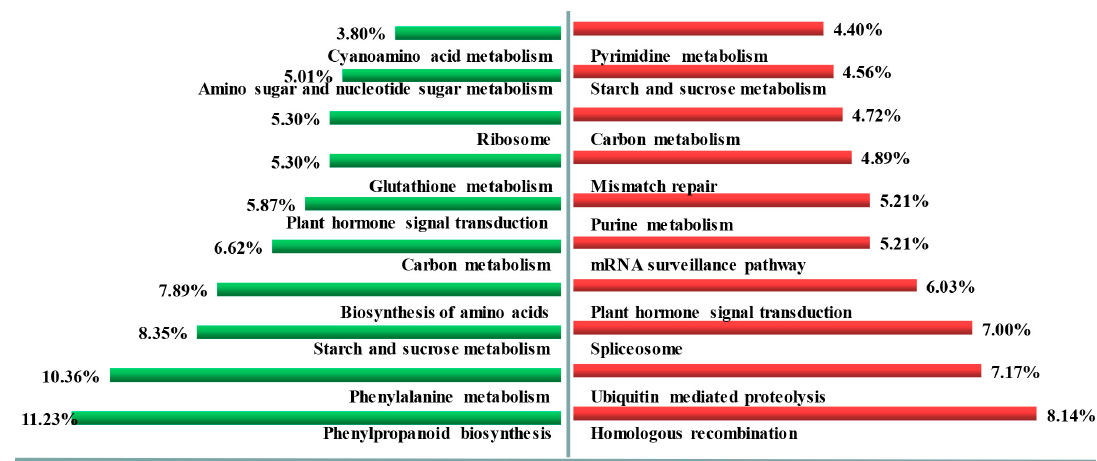
Figure 4. The top ten enhanced pathways in the tiller primordia and young spikes. Left, the enhanced pathways in tiller primordia; Right, the enhanced pathways in young spikes. Percentage, the ratio of the number of DEGs annotated to one pathway to the number of DEGs annotated to all pathways. The up-regulated genes in tiller primordia that involved top ten enriched pathways (Figure 4) were